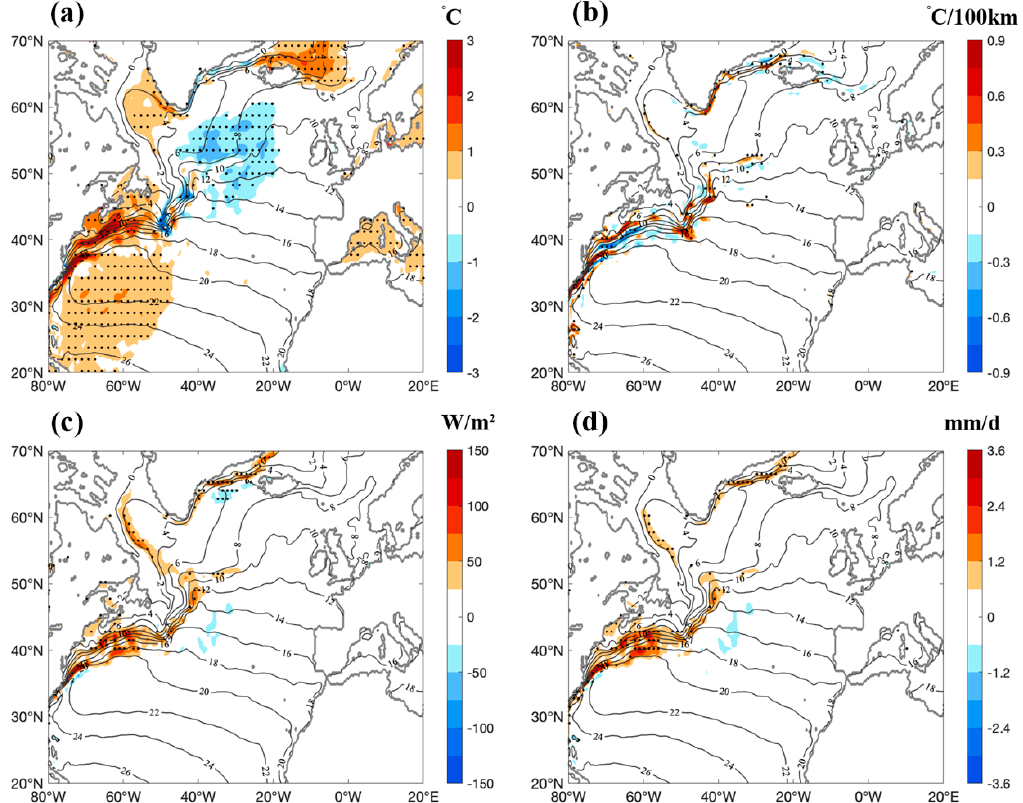
Figure 3. ( a ) Increase of OISST SST from 1997 to 2019 ( ◦ C). ( b ) As in ( a ) but for OISST SST gradient ( ◦ C / 100 km). ( c ) As in ( a ) but for turbulent heat flux (W / m 2 ). ( d ) As in ( a ) but for evaporation (mm / d). Contours are mean SST between 1997 and 2019 ( ◦ C). Black dots mark the region in which the trend passed the 95% significance level.